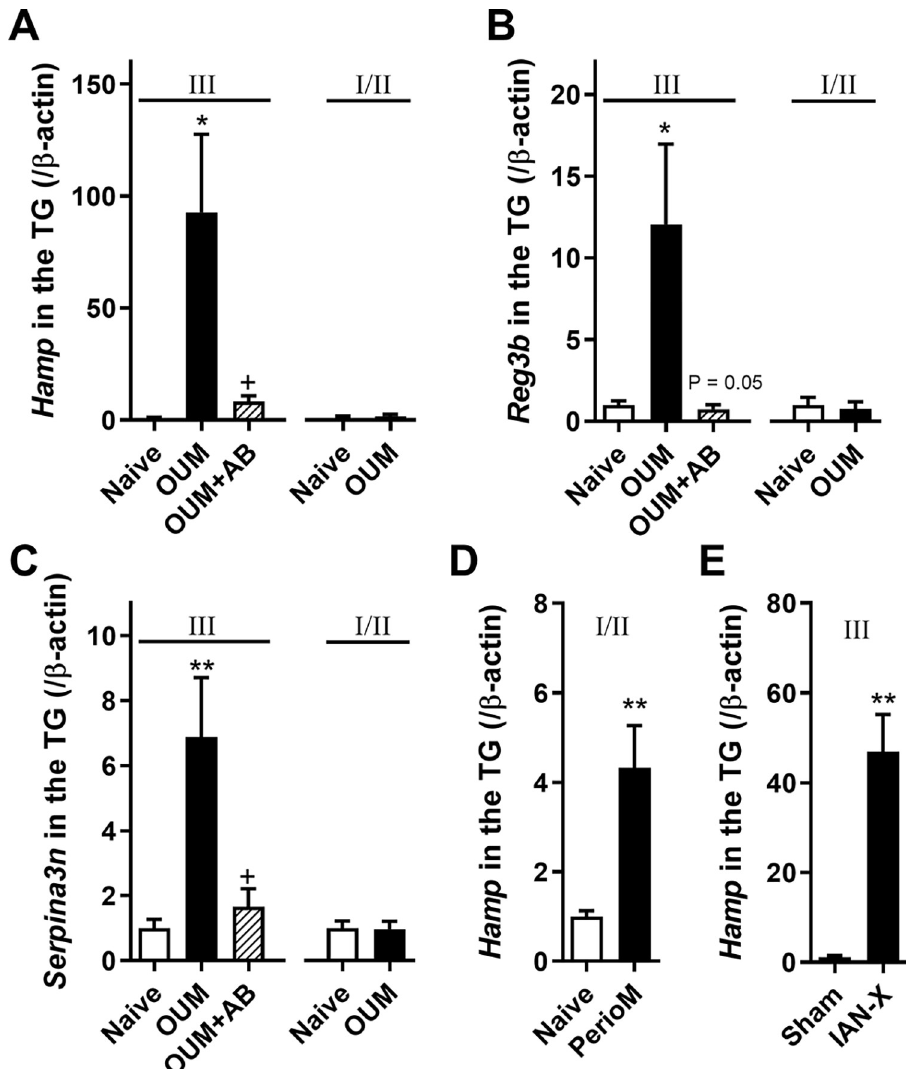
Fig 2. Changes in Hamp , Reg3b and Serpina3n mRNA levels in trigeminal ganglion (TG). All bars represent the mean ± SEM. (A) Relative expression of Hamp mRNA in the third (III) and first/second (I/II) branches of TG on day 2 in Naive, acetic acid-treated oral ulcerative mucositis (OUM) and OUM with anti-bacterial pretreatment (AB) (n = 5 in each group). ** p < 0.01 compared with Naive, Dunnett’s post hoc tests following one-way ANOVA. + p < 0.05 compared with OUM, Unpaired t-test. (B, C) Relative expression of Reg3b (B) and Serpina3n (C) mRNA in the third (III) and first/second (I/II) branches of TG on day 2 in Naive, acetic acid-treated OUM and OUM with AB (n = 5 in each group). ** p < 0.01 compared with Naive, Dunnett’s post hoc tests following one-way ANOVA. + p < 0.05, ++ p < 0.01 compared with OUM, Unpaired t-test. (D) Relative expression of Hamp mRNA in the I/II blanches of TG in the periodontitis model (perioM) rats (n = 4–5 in each group). ** p < 0.01 compared with Naive, Unpaired t-test. (E) Relative expression of Hamp mRNA in the III blanch of TG in the inferior alveolar nerve transected (IAN-X) rats (n = 4 in each group). * p < 0.05 compared with Sham, Unpaired